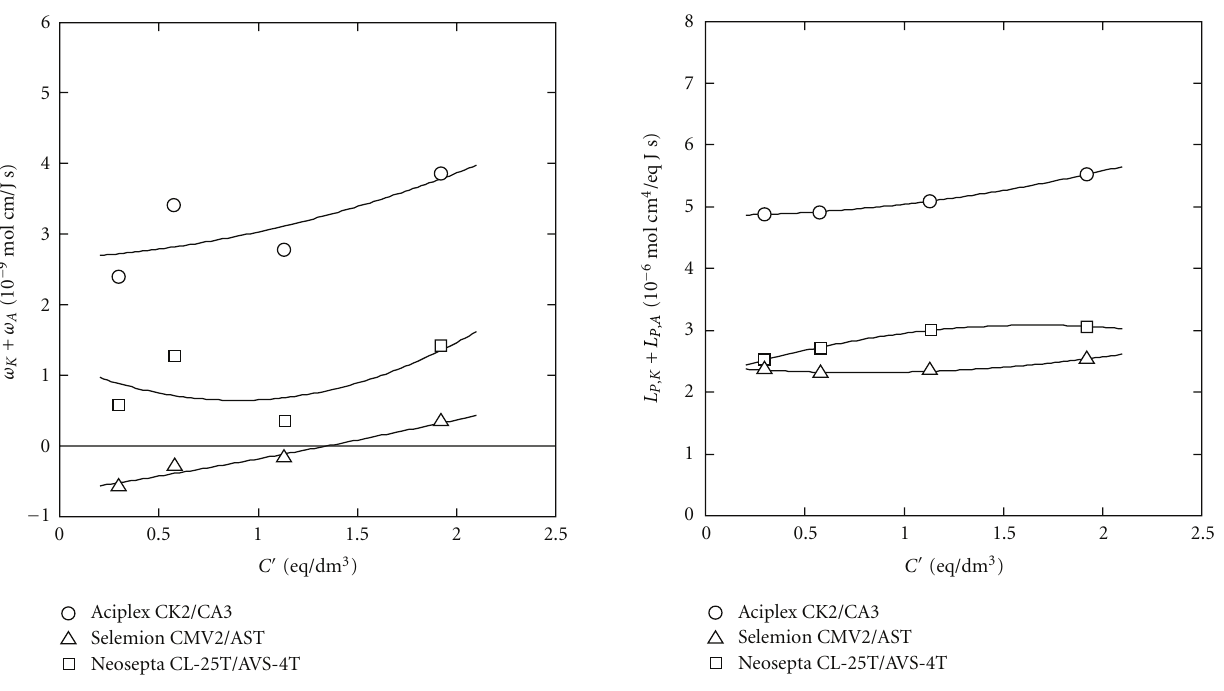
Figure 10: Relationship between salt concentration in a feeding solution and solute permeability.